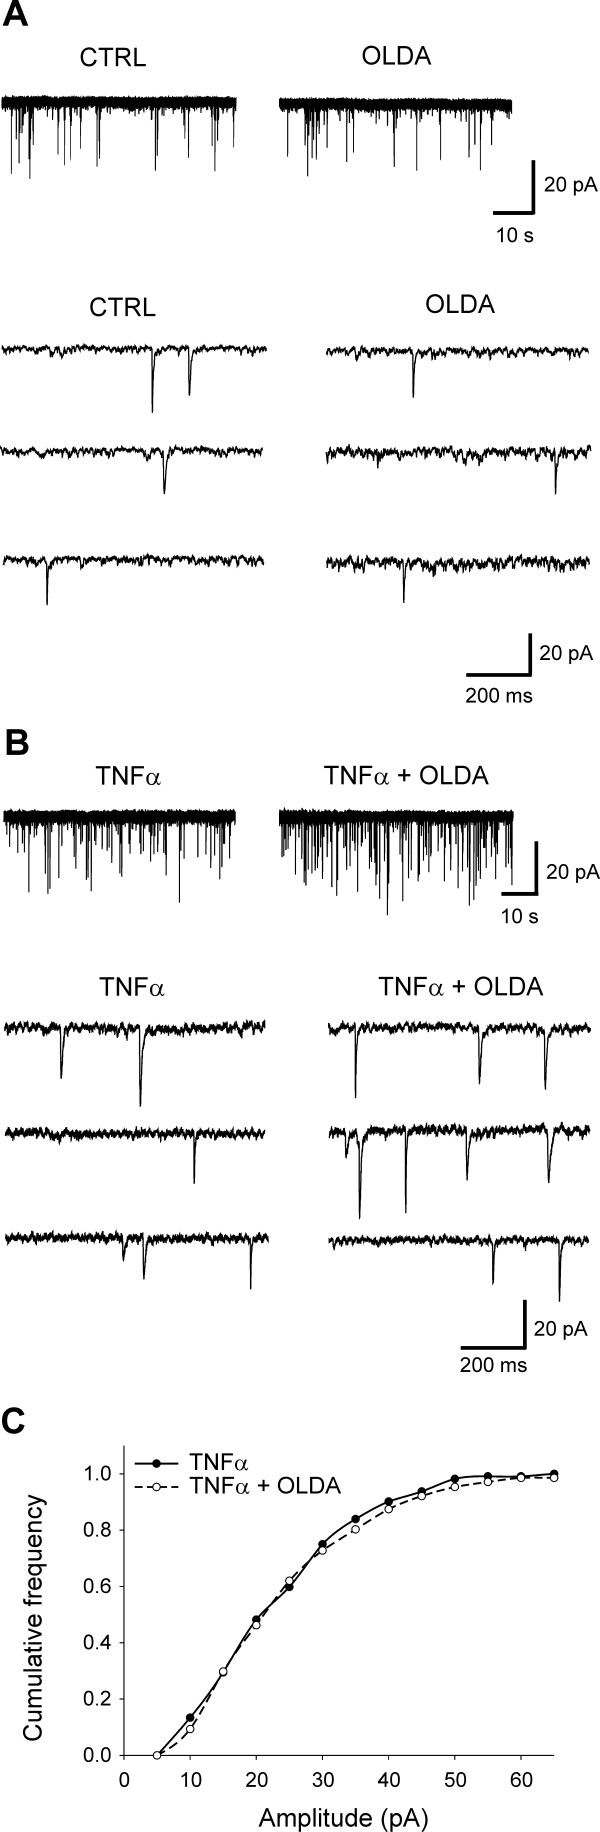
Application of a low concentration of OLDA (0.2 μM) did not change mEPSC frequency in a superficial dorsal horn neuron, as recorded under control conditions (A), while a significant increase in mEPSC frequency was observed in slices incubated with the cytokine TNFα (60 nM; B). The amplitude of the mEPSCs was not changed after OLDA application in this neuron (C).